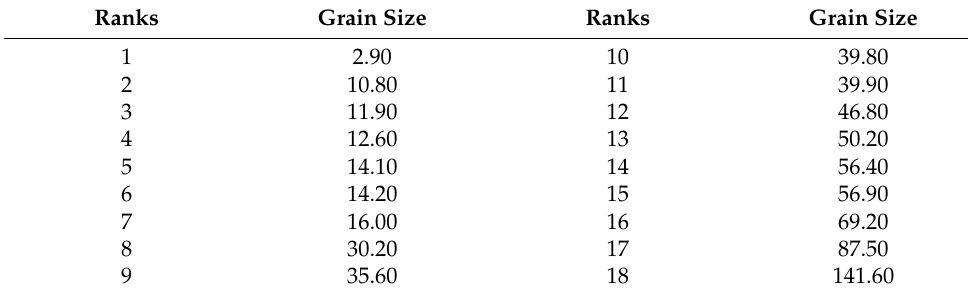
Table 2. Ranks of fine and coarse grain size from nine loess sections.